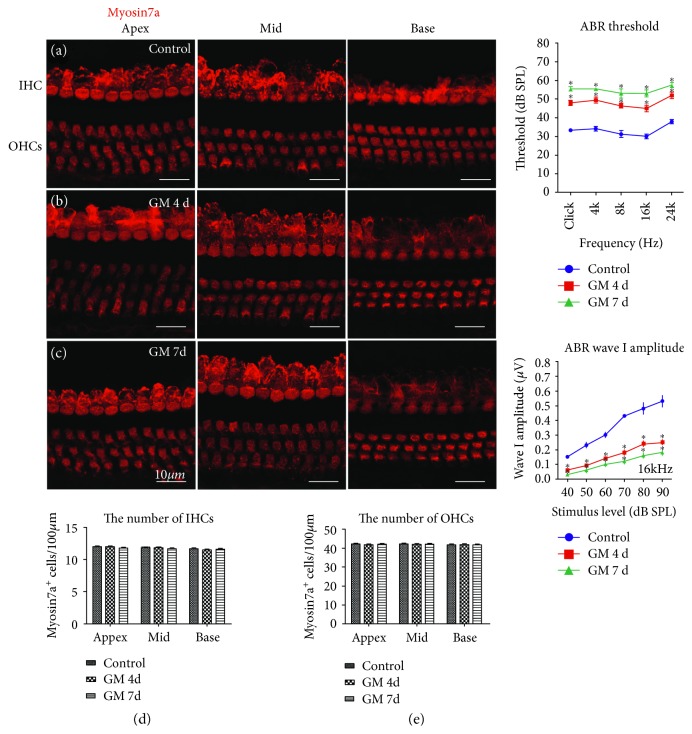
A low dose of gentamicin-induced moderate hearing loss with no obvious HC loss. The HCs were identified by immunostaining for myosin 7a (red) in the three turns of the cochlea. (a–c) After gentamicin treatment for 4 and 7 days, the morphology and arrangement of cochlear HCs were similar to the control group. (d-e) Quantitative data showed no HC loss in any of the three turns after gentamicin treatment. No significant difference was found in the number of IHCs or the three rows of OHCs among the control group and the gentamicin-treatment groups for 4 days or 7 days (p > 0.05). (f) A significant increase was observed in the ABR thresholds for clicks and for tone bursts at 4, 8, 16, and 24 kHz in the gentamicin-treated groups (∗
p < 0.05, versus the control group). (g) A significant decline was observed in the ABR wave I amplitudes at 16 kHz in the gentamicin-treated groups (∗
p < 0.05, versus the control group). GM 4 d, 7 d: gentamicin treatment for 4 days or 7 days; IHC: inner hair cell; OHC: outer hair cell. Scale bar = 10 μm. ∗
p < 0.05.